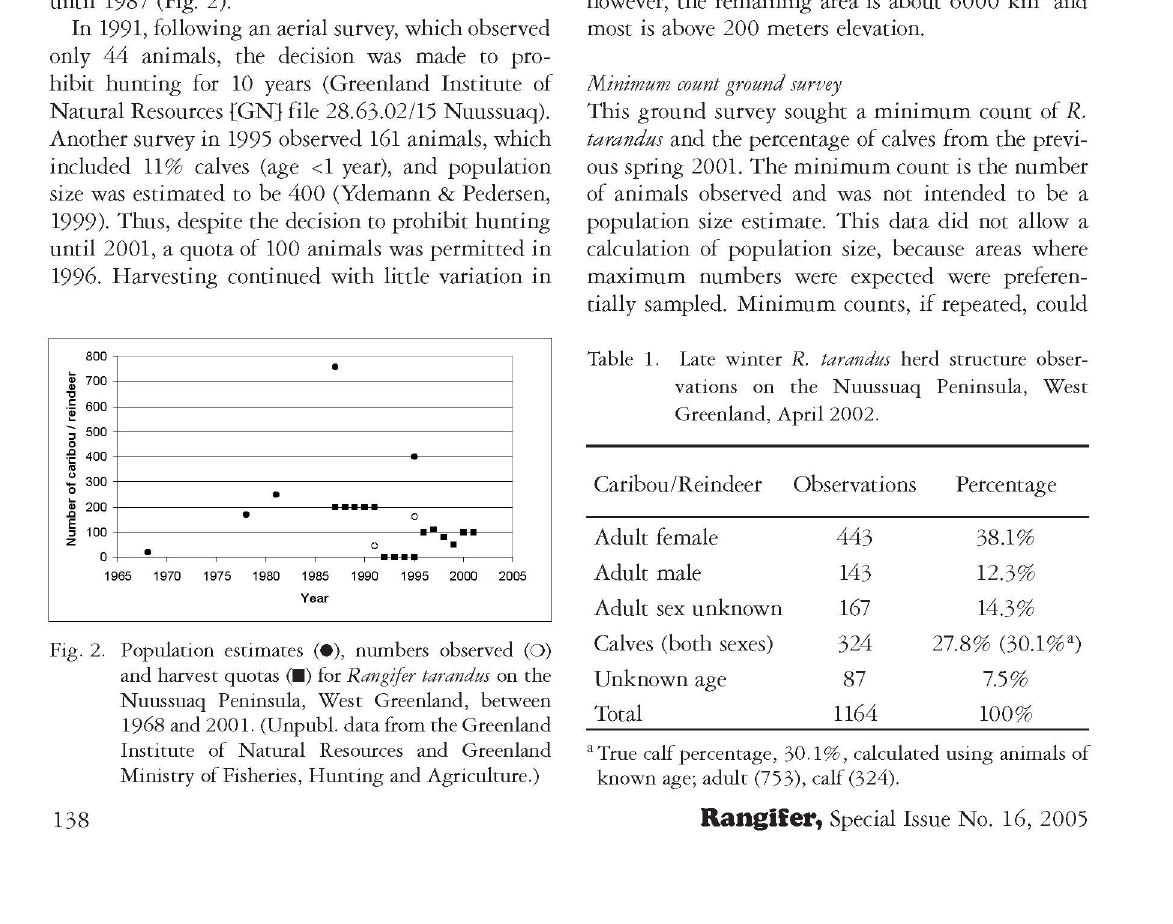
Fig. 1. West Greenland's Nuussuaq Peninsula (70—71 °N) divided into rough thirds: Western, Middle, and Eastern. Approximately 6000 km 2 non-ice covered. Shading indicates elevation.